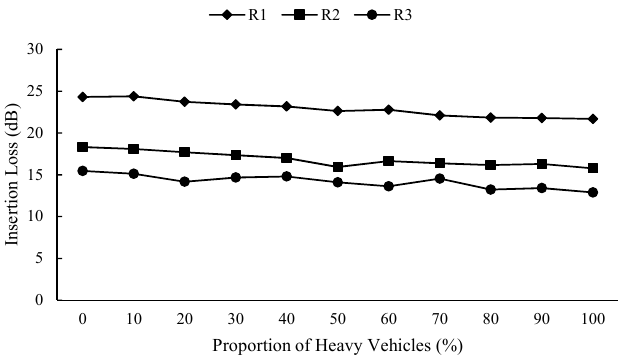
Figure 7. Insertion loss of the road barrier with different proportions of heavy vehicles.